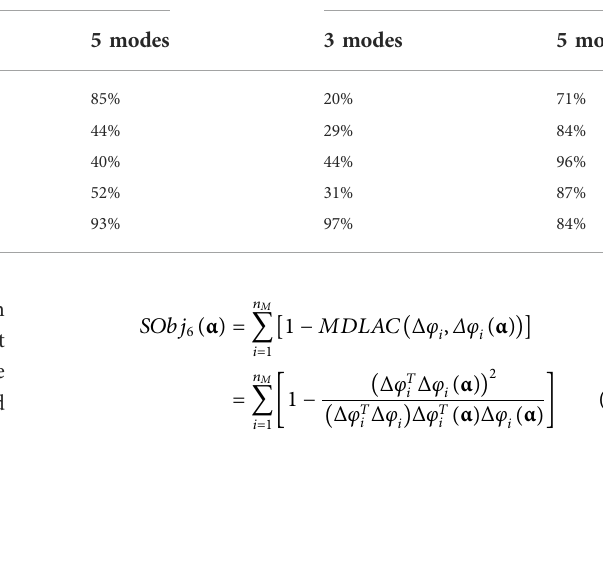
TABLE 1 DVC100 values of SDD results in case 3 based on w = 0.5. J ( α 1